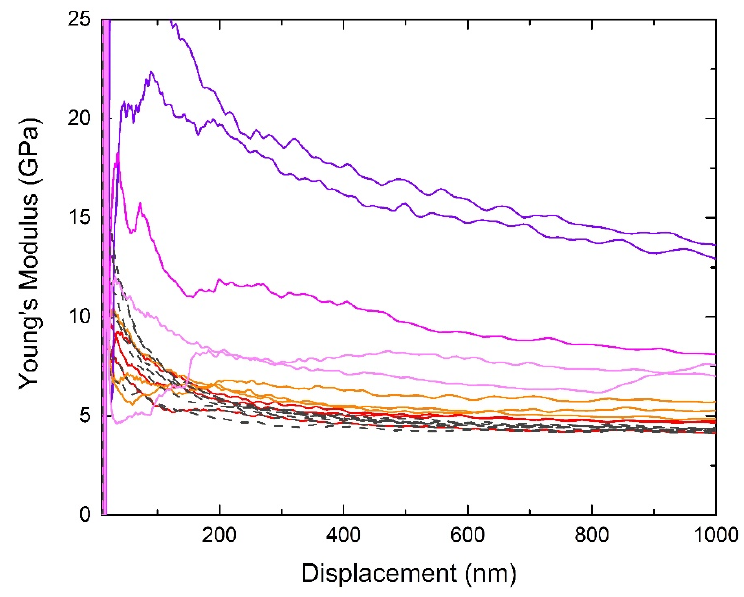
Figure 9. Modulus–displacement curves of different zones of PLLA9Mn_112 kHz composite: PLLA without heterogeneities (red and orange line), micrometric NPs clusters (purple line), and zones affected by smaller NPs aggregates (pink line). (Black dash line corresponding to PLLA9Mn.)